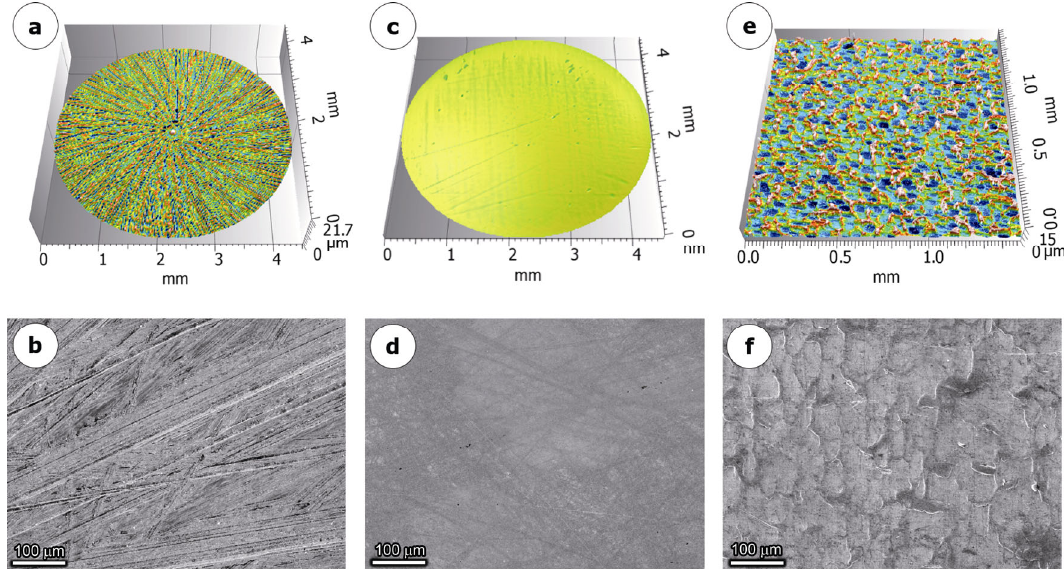
Fig. 2 Surface topographies and SEM micrographs of (a, b) as-received tool steel O, (c, d) mirror-polished tool steel O, and (e, f) as-received aluminium